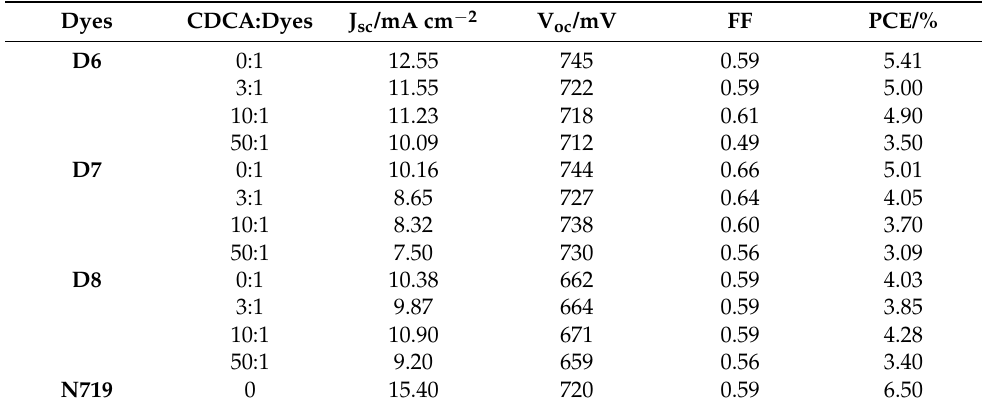
Figure 4. ( a ) Photocurrent–voltage curves and ( b ) incident monochromatic photo-to-electron conversion efficiency (IPCE) spectra and integrated current density of the dye-sensitized solar cells (DSSCs) based on the dyes. Table 4. Photovoltaic parameters of DSSCs based on dyes D6 , D7 , D8 and N719